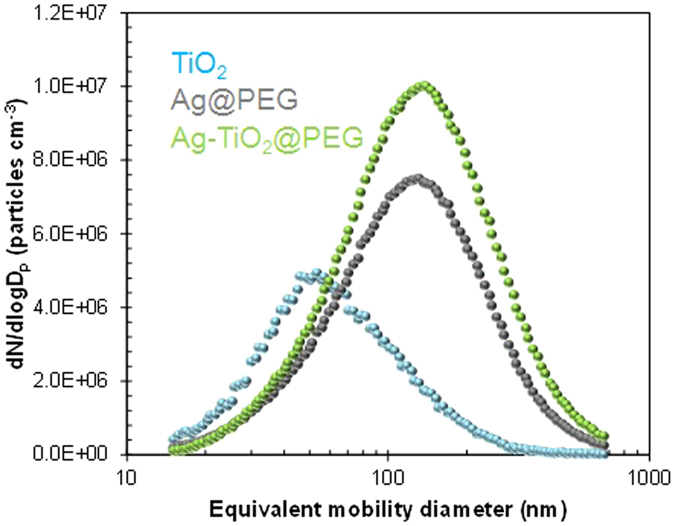
Particle size distributions of azerosol TiO2, Ag@PEG,
and Ag-TiO2@PEG nanoparticles.